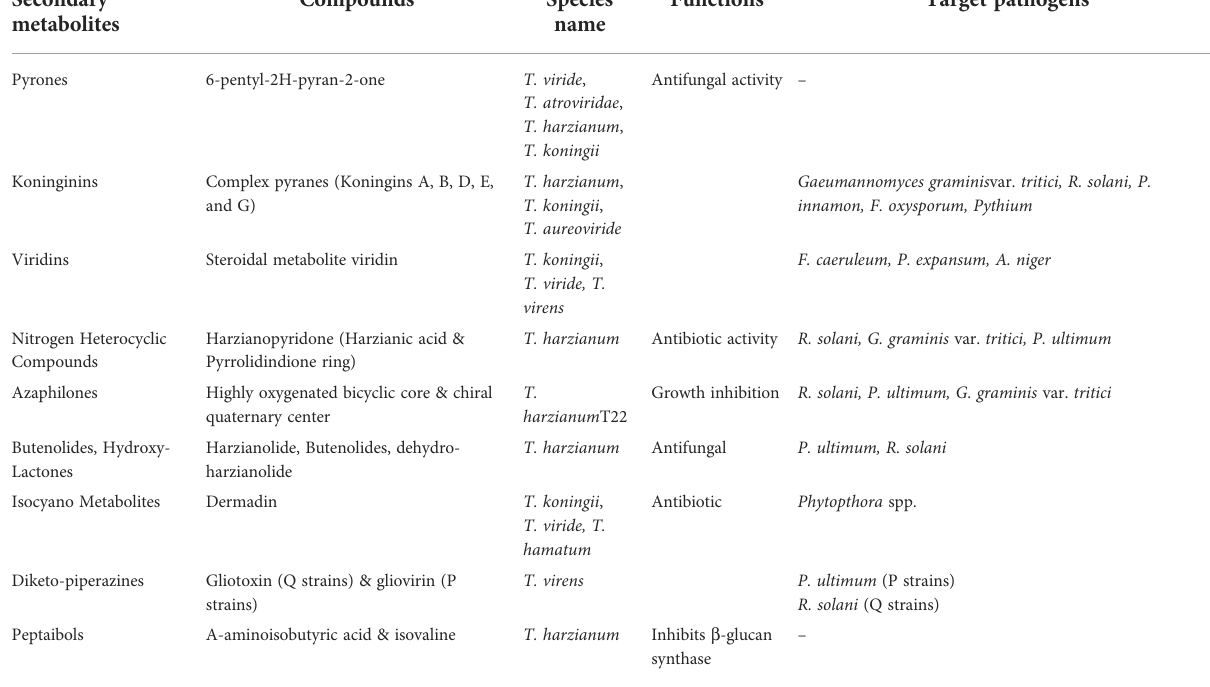
TABLE 2 Different types of secondary metabolites produced by Trichoderma